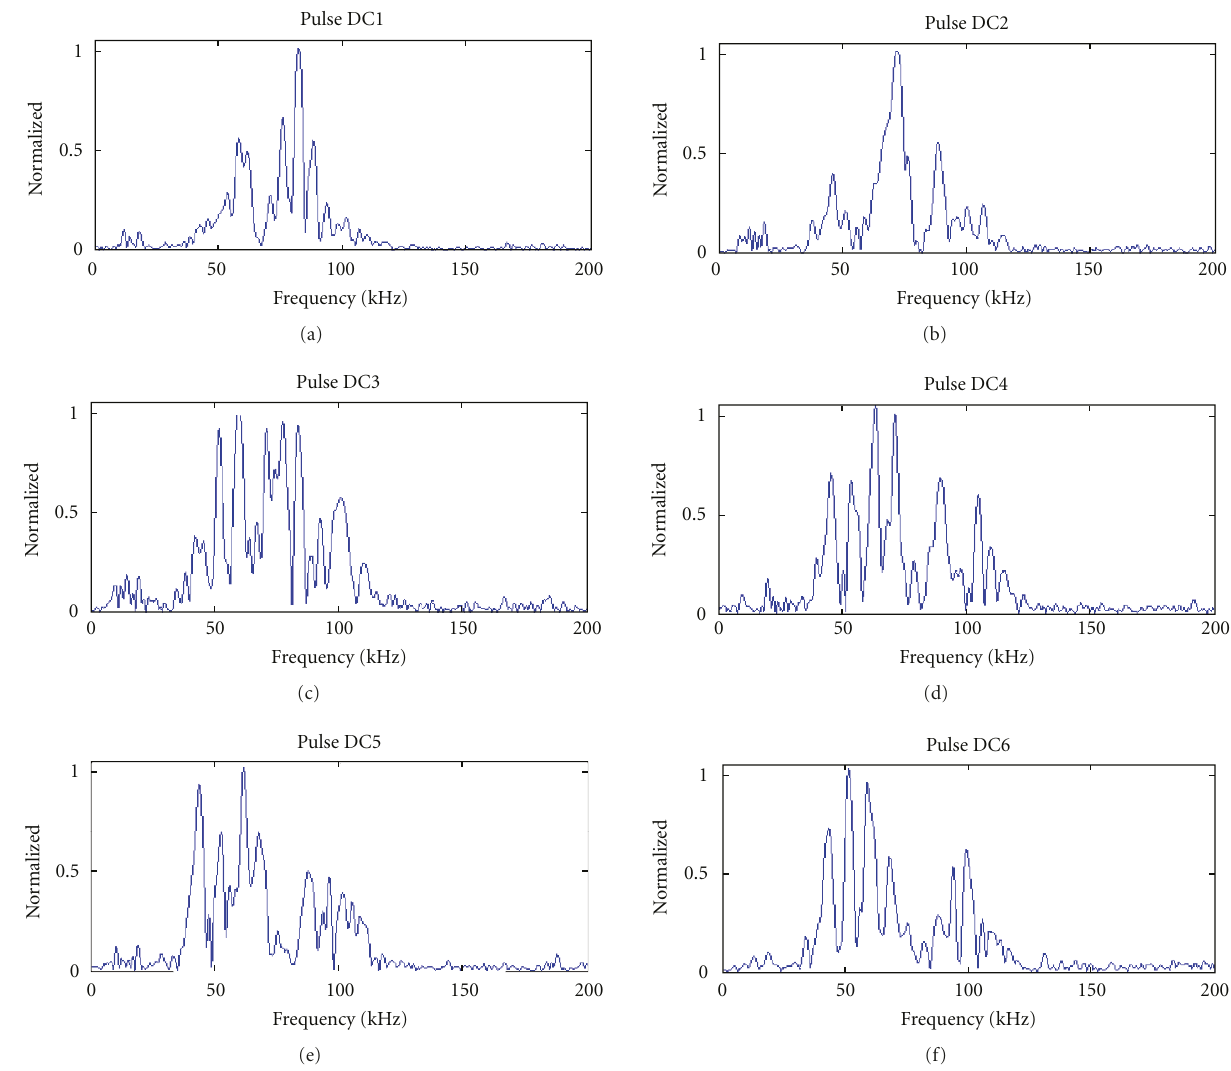
Figure 20: Spectral responses for the same concrete block tilted relative to the sonar beam axis ( ≈ 30 ◦ ), pulses